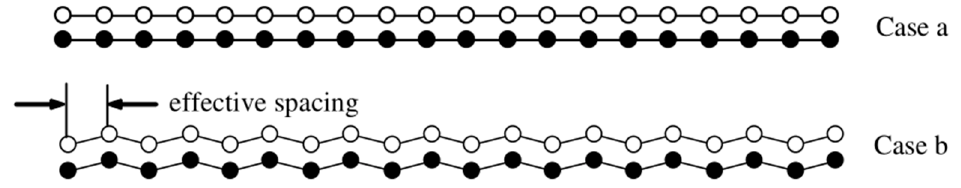
Figure 1. Schematic illustration of two different types of atom row matching at the interface. Reprinted with permission from [15], 2005, Elsevier.